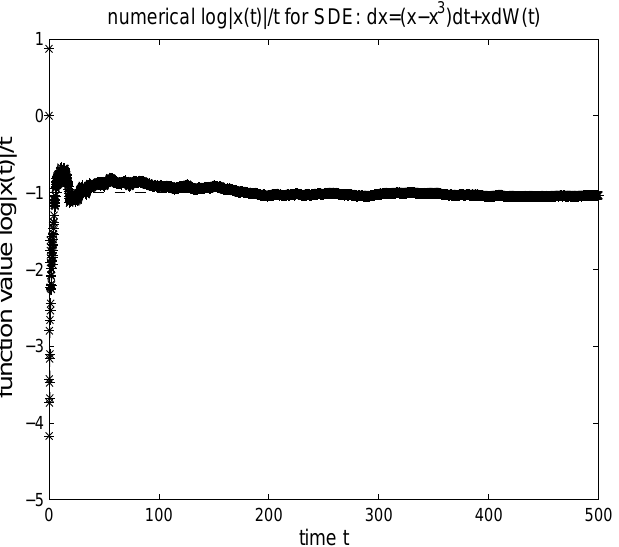
Figure 7. Numerical simulation of log | x ( t ) | / t for the equation: dx = ( x − x 3 ) dt + xdW ( t ) . The time-interval: [0,500], the stepsize: dt = 0.1, the initial value: X ( 0 ) =